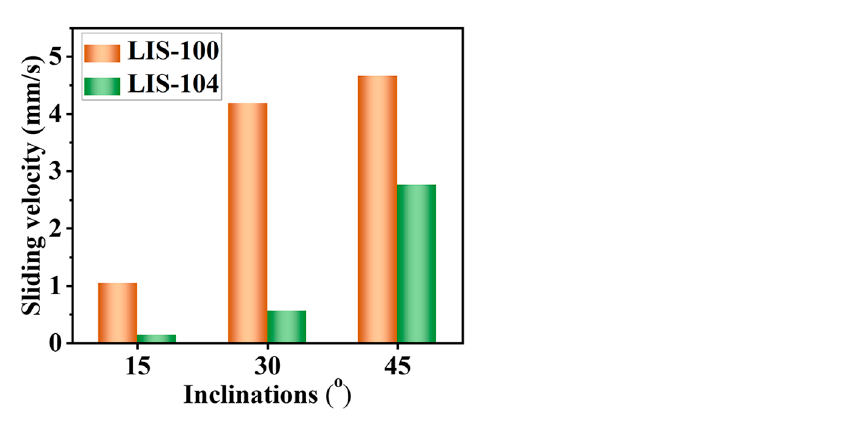
Figure 10. The sliding velocity of water droplet on LIS-100 and LIS-104 surfaces with different inclination angles.